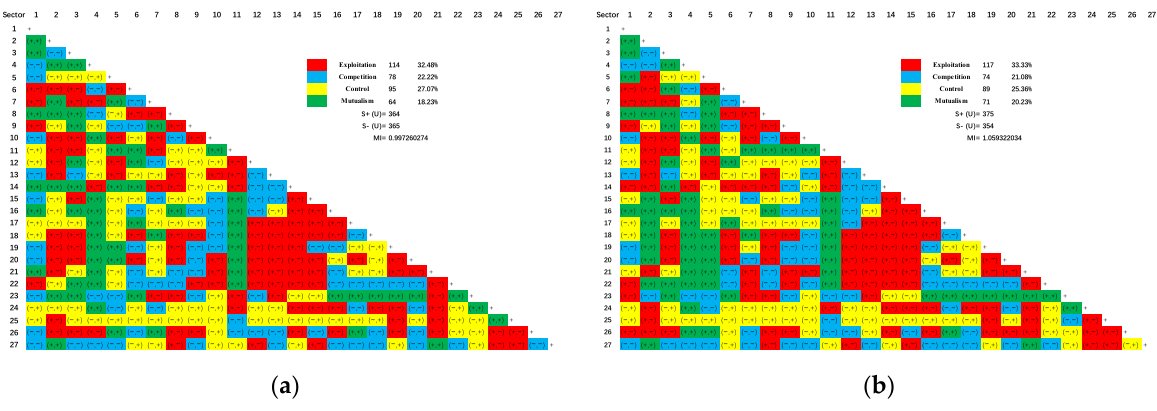
Figure 7. Pairwise utility relationships between sectors. ( a ) NO x ; ( b ) PM.